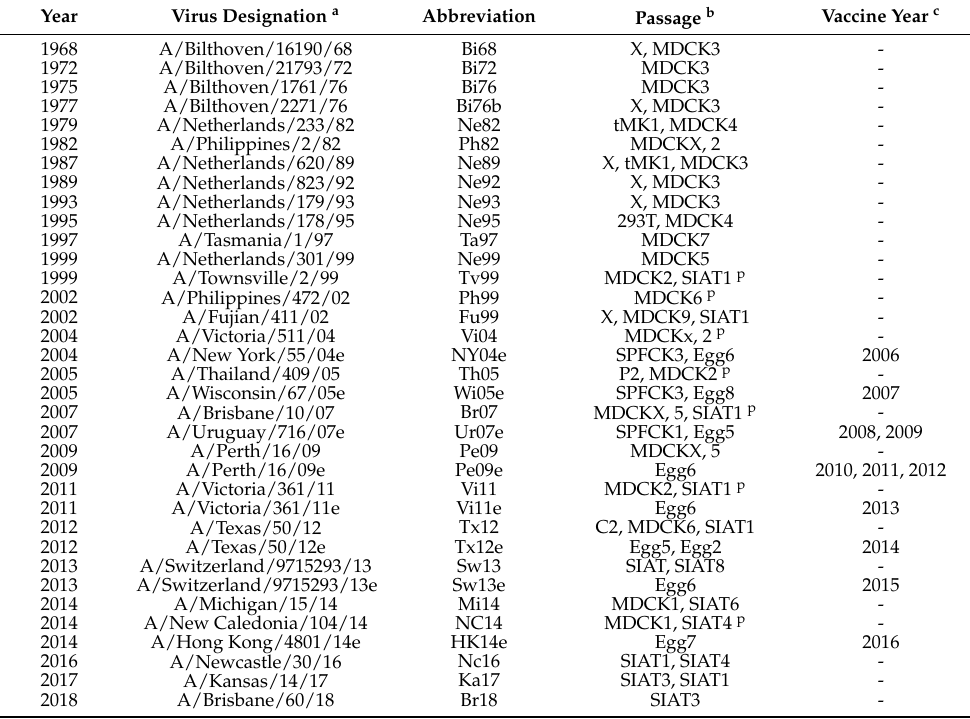
Table 1. Viruses used for antibody assays.